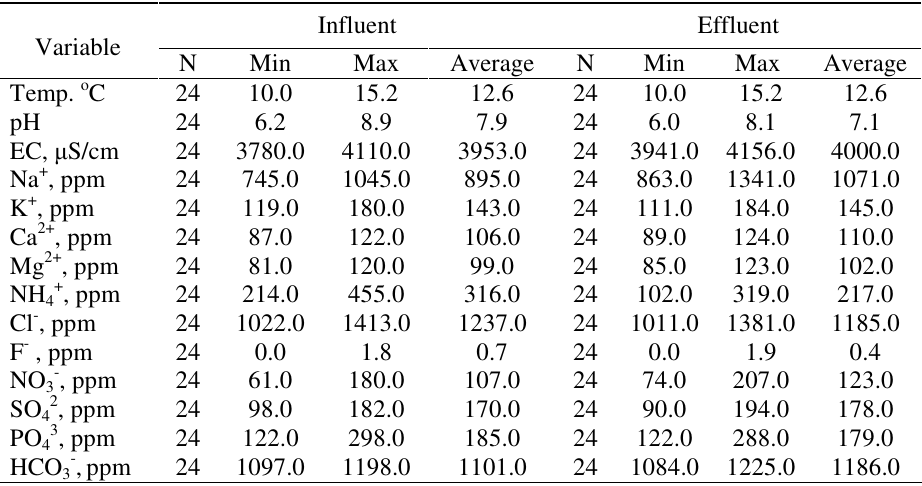
Table 2. Physicochemical parameters for wastewater effluent in winter season.